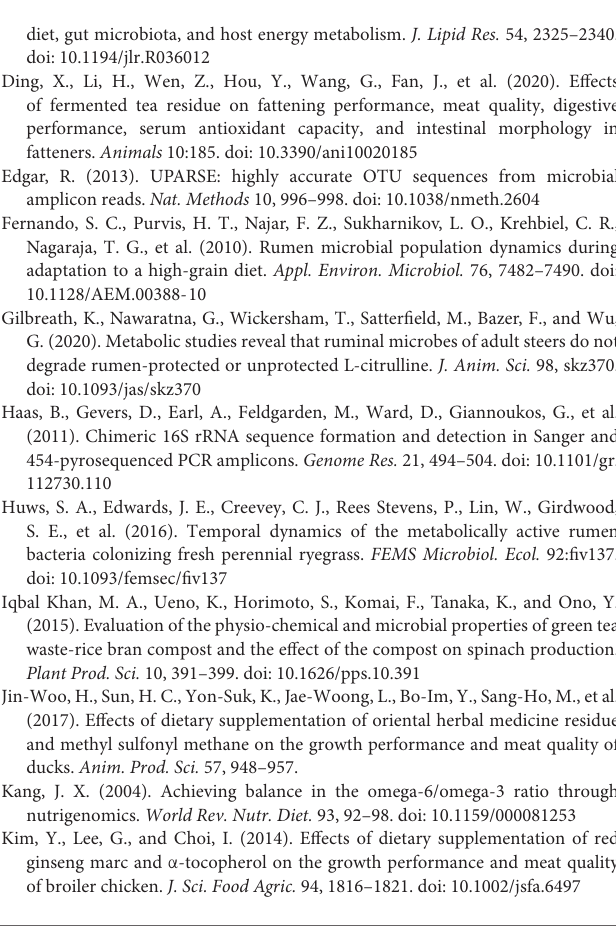
Supplementary Figure 1 | Differential metabolites annotation statistics in HMDB (A) and LIPID MAPS (B) database. The left picture is the positive ion mode, and the right picture is the negative ion mode. The X-axis represents the number of metabolites, and the y-axis represents the term of HMDB or LIPID MAPS. Supplementary Figure 2 | The PLS-DA scatter plots of each sample in positive (left) and negative (right) modes. The abscissa is the score of the sample on the first principal component; The ordinate is the score of the sample on the second principal component; R2Y represents the explanatory rate of the model, and Q2Y is used to evaluate the predictive ability of the PLS-DA model. When R2Y is greater than Q2Y, the model is well established. Supplementary Figure 3 | Correlation analysis of rumen microorganisms with rumen volatile fatty acid concentrations. Each cell contains the corresponding correlation and P -value. The table is color-coded by correlation according to the color